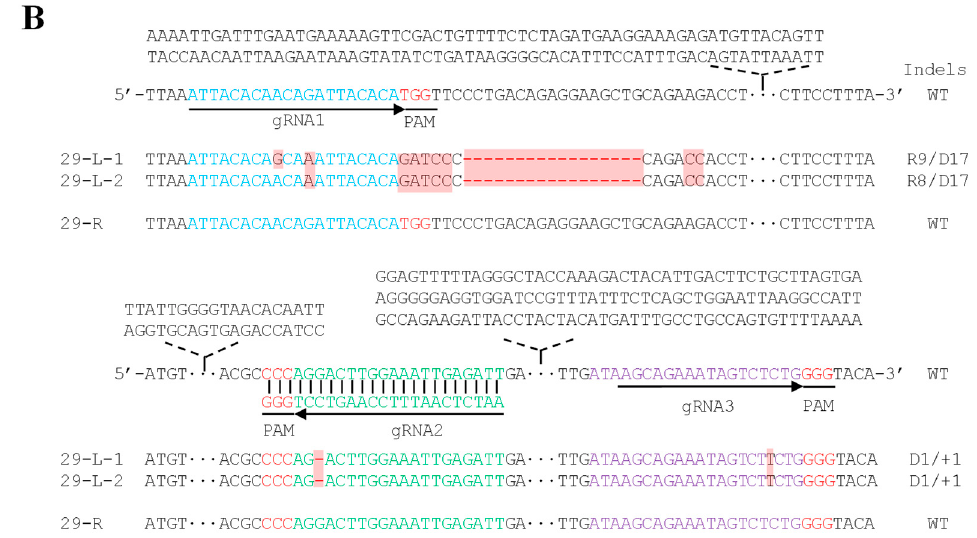
Figure 5. Nodulation phenotype and sequencing of SYMRK in a split-root system. The transgenic hairy roots were inoculated with Sinorhizobium sp. NGR234. Pictures were taken after 3 weeks post inoculation (3 wpi). ( A ) Nodulation phenotype of hairy roots. Line 29-L, left part root of line 29; Line 29-R, right part root of line 29. ( B ) Mutations around gRNA target sites of VuSYMRK gene. Blue font, gRNA1; green font, gRNA2; purple font, gRNA3; red font, PAM sequence; WT, wild-type sequence; D1 / 17, 1 bp or 17 bp nucleotide deletions; R8 / 9, 8 bp or 9 bp nucleotide replacements; + 1, 1 bp insertion; DNA replacements, insertions and deletions are highlighted in red.